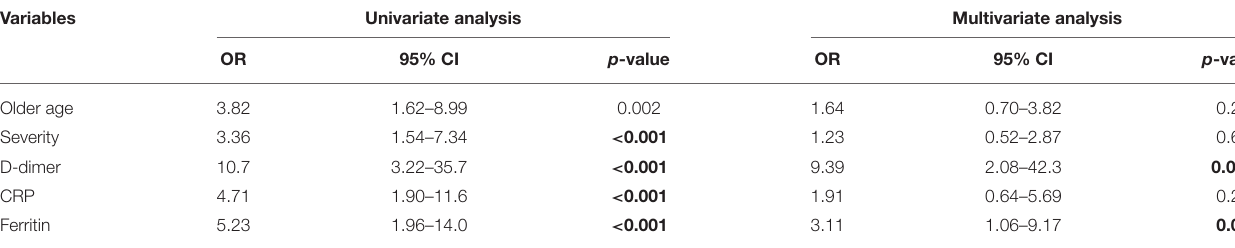
TABLE 2 | Univariate analysis and multivariate logistic regression analysis adjusted for the variables. Variables